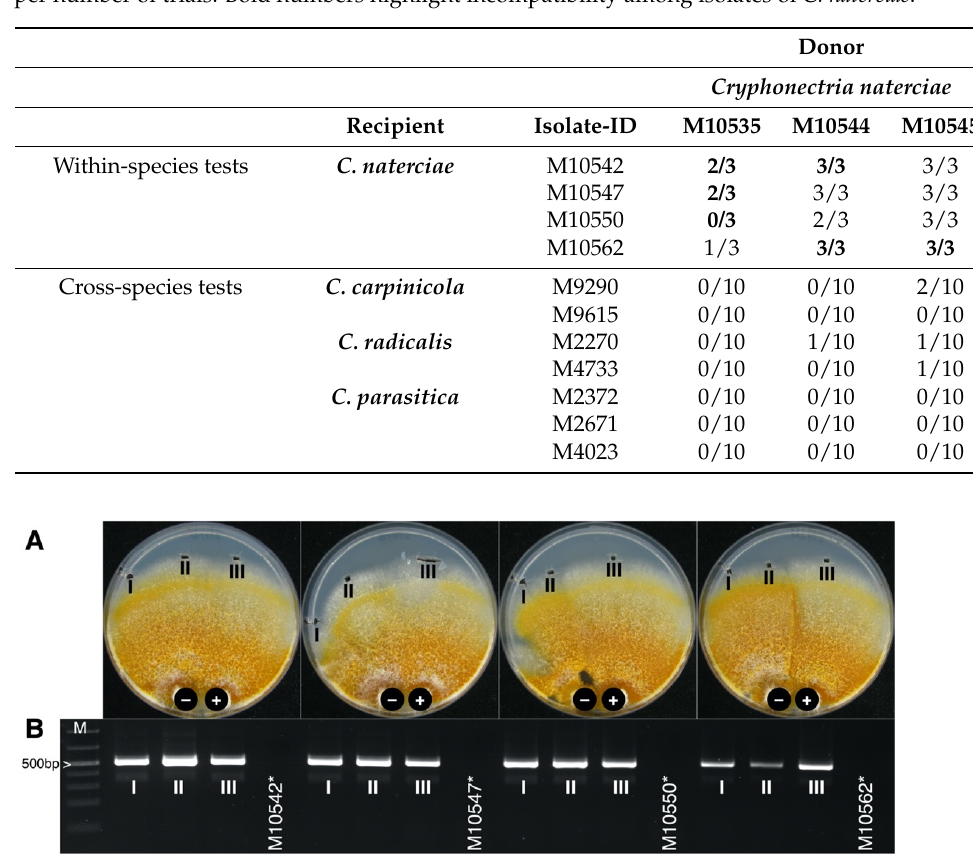
Figure 5. Pairwise co-cultivation of CnFGV1-positive (+) and CnFGV1-free ( − ) strains of C. naterciae . ( A ) After incubation for 10–15 days at 25 °C, two inocula from the recipient side (I and II) and one from the donor side (III) were sub-cultivated for 4–5 days. ( B ) Gel electrophoresis of Cn-Vir-ORF1 fragments used to verify the virus presence. Negative controls of pairing tests are virus-free strains labeled with asterisks. M: Thermo Scientific GeneRuler 1 kb Plus DNA Ladder (SM1334).